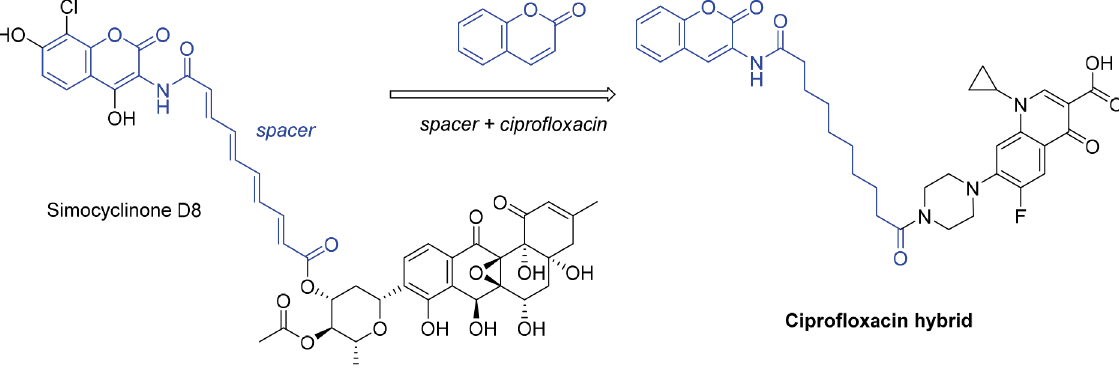
FIGURE 7 - Fragment selection from natural products for developing new bioactive